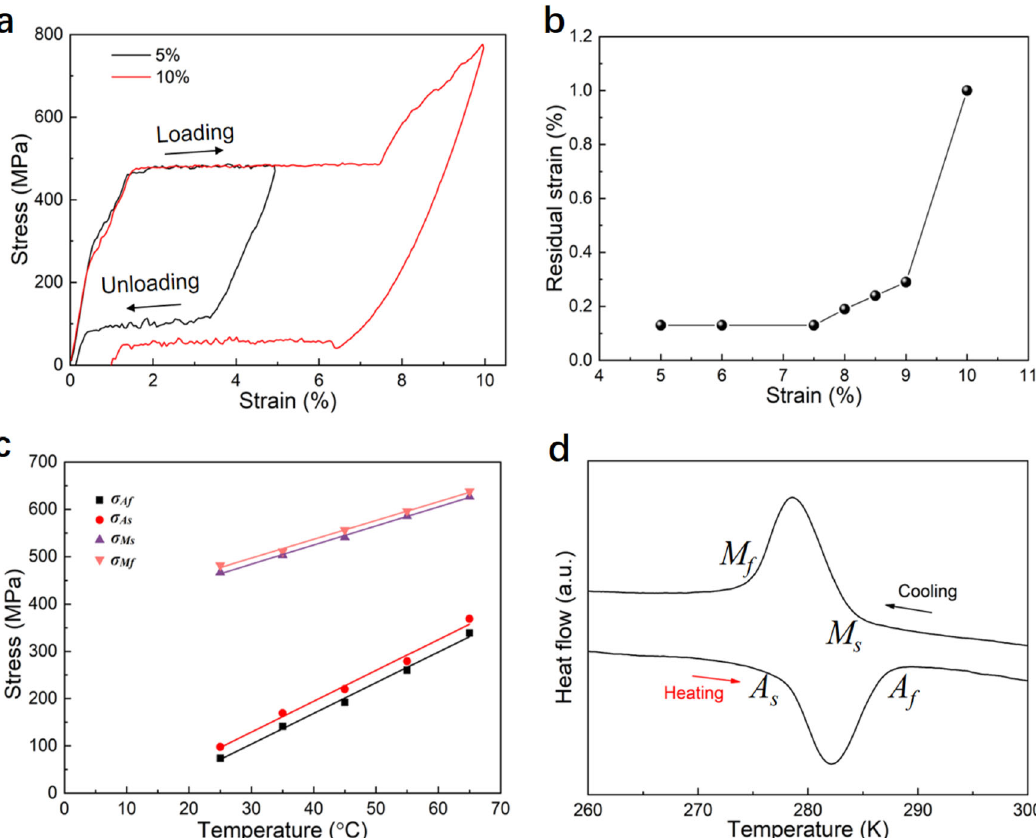
Fig. 3 Mechanical and thermal properties of Ni-Ti wires. a Loading-unloading stress-strain curves of the straight Ni-Ti wire with a diameter of 30 μ m under various levels of applied tensile strain at room temperature. b The dependence of the residual strain on the applied tensile strain. c Linear fi tting of the critical stresses versus temperature, the parameters C M and C A is de fi ned by the slopes of the fi tting line. d DSC measurement of the straight Ni-Ti wires at a heating/cooling rate of 5 °C/min, showing the transformation